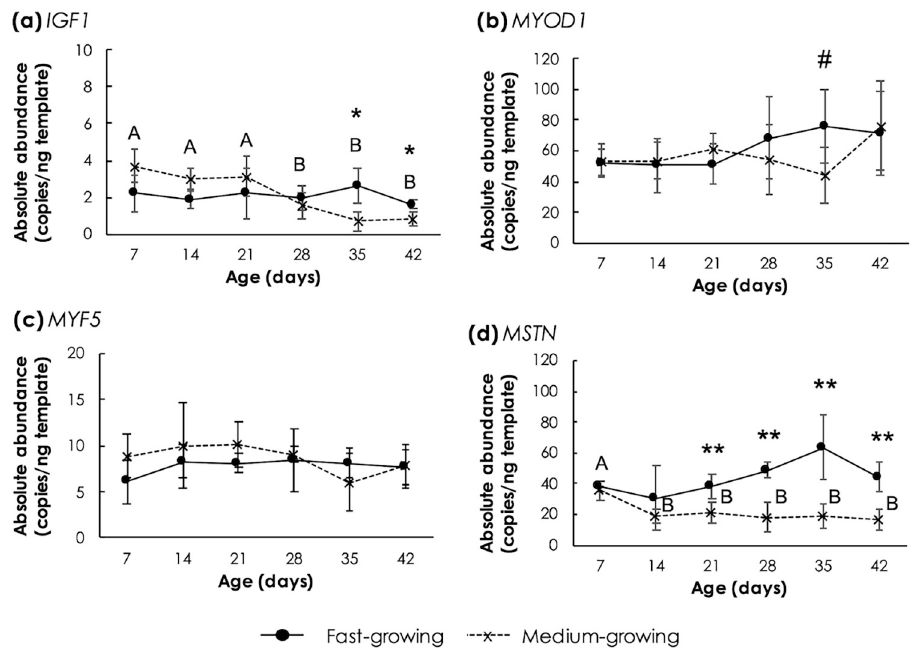
Fig 1. Absolute transcript abundance of genes involved in muscle growth in Pectoralis major muscle of fast- and medium-growing chickens at different ages. The genes include (a) insulin-like growth factor 1 ( IGF1 ), (b) myogenic differentiation 1 ( MYOD1 ), (c) myogenic factor 5 ( MYF5 ) and (d) myostatin ( MSTN ). Markers and error bars depict mean value and standard deviation (n = 5). Upper case letters indicate significant differences among medium-growing chickens. Asterisks and sharps indicate significant differences between the two strains at the same age. # p < 0.1, � p < 0.05, �� p < 0.01.